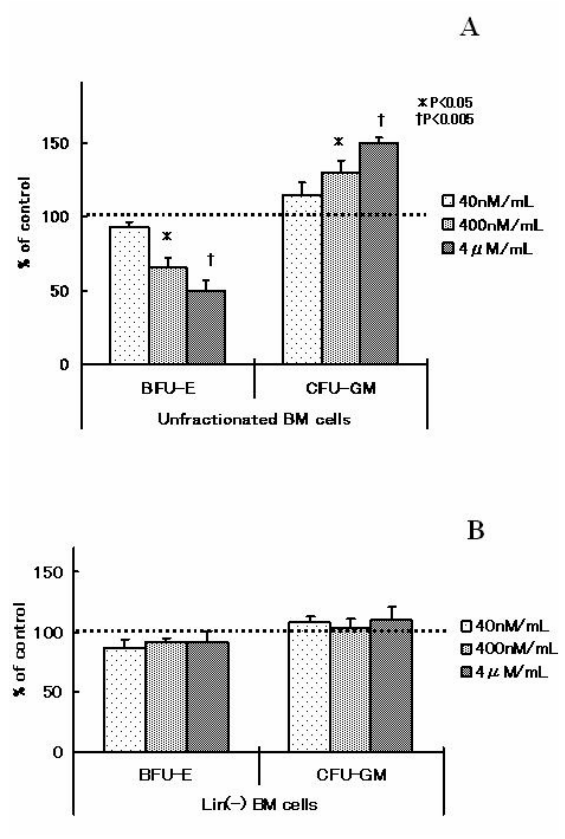
Figure 1: Formation of BFU-E and CFU-GM colonies by unfractionated bone marrow (BM) cells and frac- tionated lineage-negative BM-cells [Lin (-) BM cells] in the presence of neopterin. Unfractionated BM cells ( 5x10 5 cells/dish for BFU-E or 2x10 4 cells/dish for CFU-GM ) or Lin(-) BM cells (2x10 4 cells/dish for BFU-E or 8x10 3 cells/dish for CFU-GM) were incu- bated in the methylcellulose culture system containing IL-3 and erythropoietin for BFU-E or GM-CSF for CFU-GM with or without neopterin. The numbers of BFU-E and CFU-GM colonies were determined after 10 days and 7 days, respectively. Each bar represents the mean ± SD obtained from triplicate experiments. The absolute number of BFU-E and CFU-GM colonies in control (without neopterin treatment) cul- tures were, 19.3 ± 1.1/5x10 5 and 41.5 ± 1.8/2x10 4 for unfractinated BM cells ,and 29.7 ± 2.5/2x10 4 cells/dish and 32.7 ± 1.1/8x10 3 cells/dish for Lin (-) BM cells,